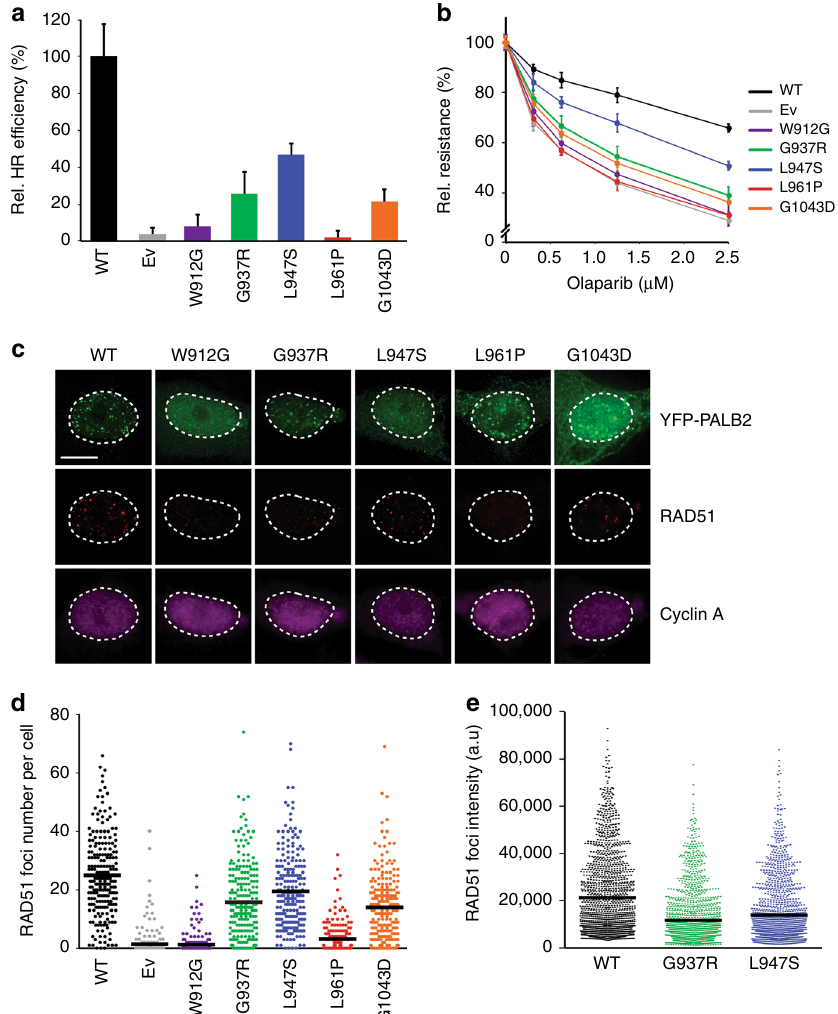
Fig. 7 Functional analysis of damaging PALB2 variants in human cells. a CRISPR-LMNA HDR assay in siRNA-treated U2OS PALB2 knockdown cells expressing siRNA-resistant human PALB2 cDNA with the indicated variants (or an empty vector control, Ev). Data represent the mean percentage (±SD) of mRuby2-positive cells among the YFP-positive cells from three independent experiments ( n > 300 YFP-positive cells per condition) relative to wild type (WT), which was set to 100%. b PARP inhibitor (PARPi) sensitivity assay using siRNA-treated HeLa PALB2 knockdown cells expressing siRNA-resistant human PALB2 cDNA with the indicated variants (or an empty vector control, Ev). Survival curves were determined after 72 h of PARPi treatment. Data represent the mean percentage of viability relative to untreated cells ( ± SD), which was set to 100%, of three independent experiments, each performed in triplicate. c Representative images of RAD51 foci 4 h after 2 Gy of ionizing radiation in siRNA-treated HeLa PALB2 knockdown cells expressing siRNA- resistant human PALB2 cDNA with the indicated variants (or an empty vector control, Ev). Scale bar: 5 µ m. d Quanti fi cation of the results from ( c ). Scatter dot plot shows the number of RAD51 foci in cyclin A-positive cells expressing the indicated variant, with the horizontal lines designating the mean values (±SD) of three independent experiments ( n > 200 cells per condition). e Quanti fi cation of the results from ( c ). Scatter dot plot shows the intensity of RAD51 foci in cyclin A-positive cells expressing the indicated variant, with the horizontal lines designating the mean values (±SD) of three independent experiments ( n > 500 cells per condition). Source data are provided as a Source Data fi